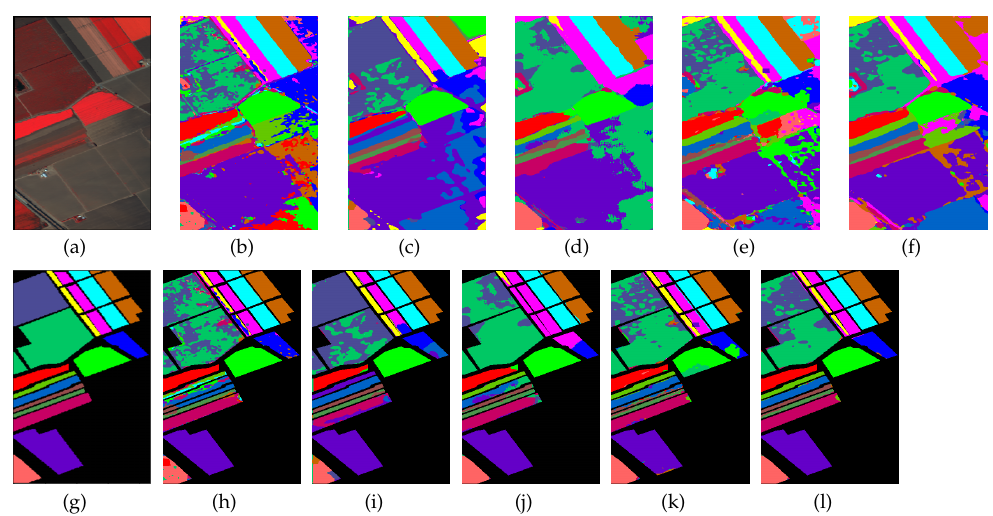
Figure 7. Classification maps generated by all of the competing methods on the Salinas Scene data with 0.1% training samples. ( a , g ) are false-color images and ground-truth maps respectively, while ( b – f ) and ( h – l ) are the results of HybridSN, SSRN, A-SPN, MCNN-CP, and Oct-MCNN-HS,